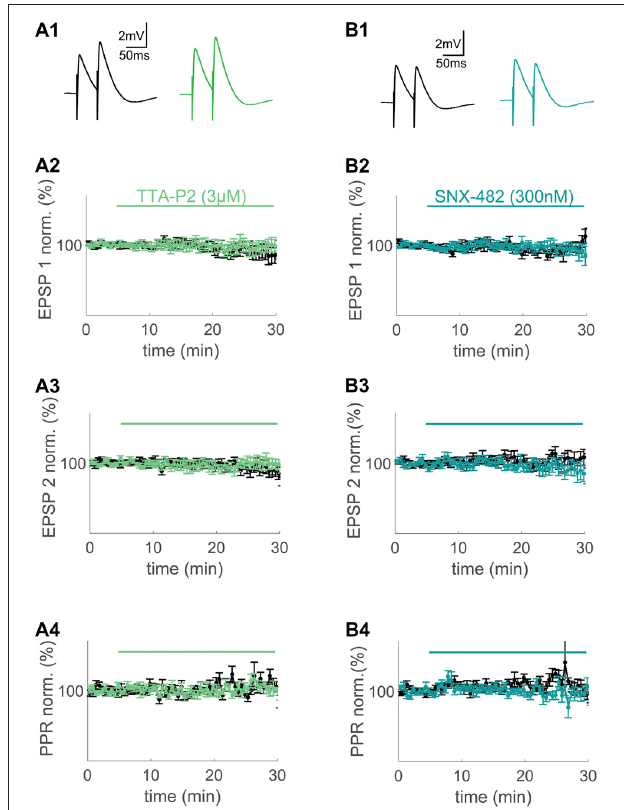
FIGURE 2 | T- and R-type VGCCs do not contribute to synaptically evoked compound excitatory postsynaptic potentials (EPSPs) measured at the soma. (A1,B1) Extracellular synaptic paired-pulse stimulation evoked compound EPSPs under control conditions (black) and after wash-in of 3 µ M TTA-P2 (green) and 300 nM SNX-482 (blue) 20–25 min after wash-in. (A2,A3,B2,B3) Time plots of normalized, binned (1 min) maximum amplitudes of EPSP1 (A2,B2) and EPSP2 (A3,B3) under control conditions (black) and during wash-in of TTA-P2 (green) and SNX-482 (blue). (A4,B4) Paired-pulse ratio (PPR) of the control conditions (black) and during wash-in of TTA-P2 (green) and SNX-482 (blue).